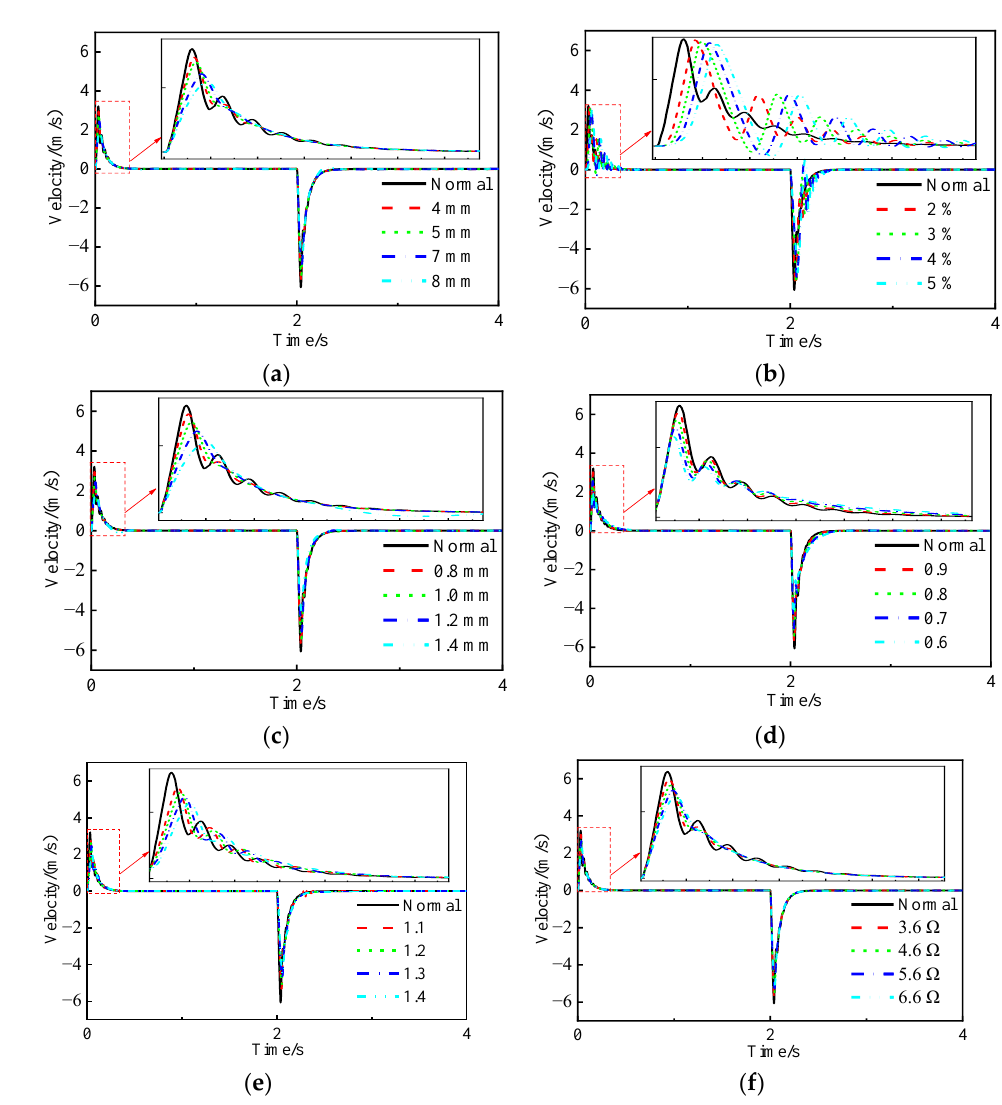
Figure 12. Velocity response of actuator cylinder under different faults: ( a ) Internal leakage of hydraulic pumps; ( b ) Oil mingled with air; ( c ) Internal leakage of actuator; ( d ) Friction increases; ( e ) Loss of sensor gain; ( f ) Resistance increases.